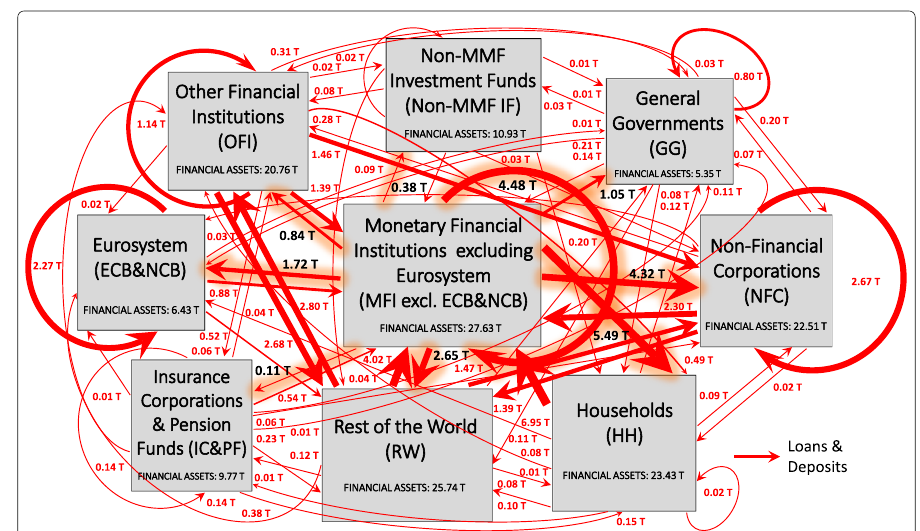
Fig. 5 The euro area macro-network of financial exposures via loans and deposits; June 2017. The macro-network of financial exposures among the different institutional sectors operating in the euro area (i.e., Eurosystem (ECB&NCB), Monetary Financial Institutions excluding the Eurosystem (MFI excl. ECB&NCB), Other Financial Institutions (OFI), Non-MMF Investment Funds (Non-MMF IF), Insurance Corporations and Pension Funds (IC&PF), Households (HH), Non-Financial Corporations (NFC), and General Governments (GG)), and the Rest of the World (RW), via short-term and long-term loans and deposits (represented with red links), with reference to the second quarter of 2017. Weights represent the outstanding financial exposures of a source institutional sector to a target institutional sector expressed in trillion euros. Data source: (European Central Bank 2017b)